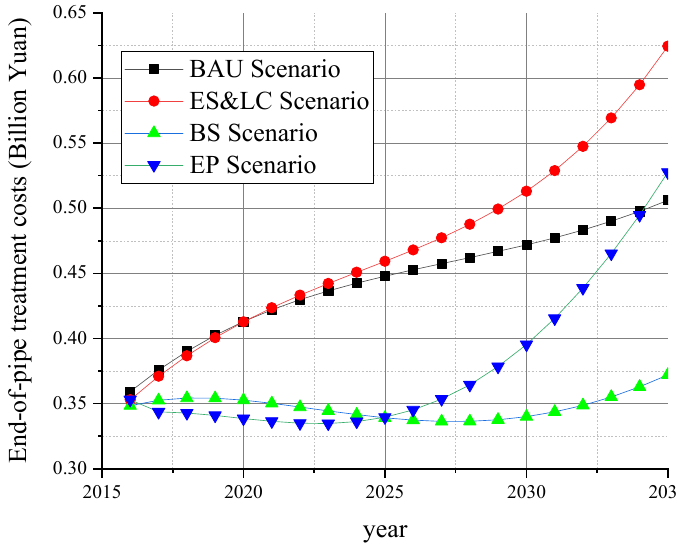
Figure 6. End-of-pipe costs of the BAU EP ES&LC and BS scenarios.